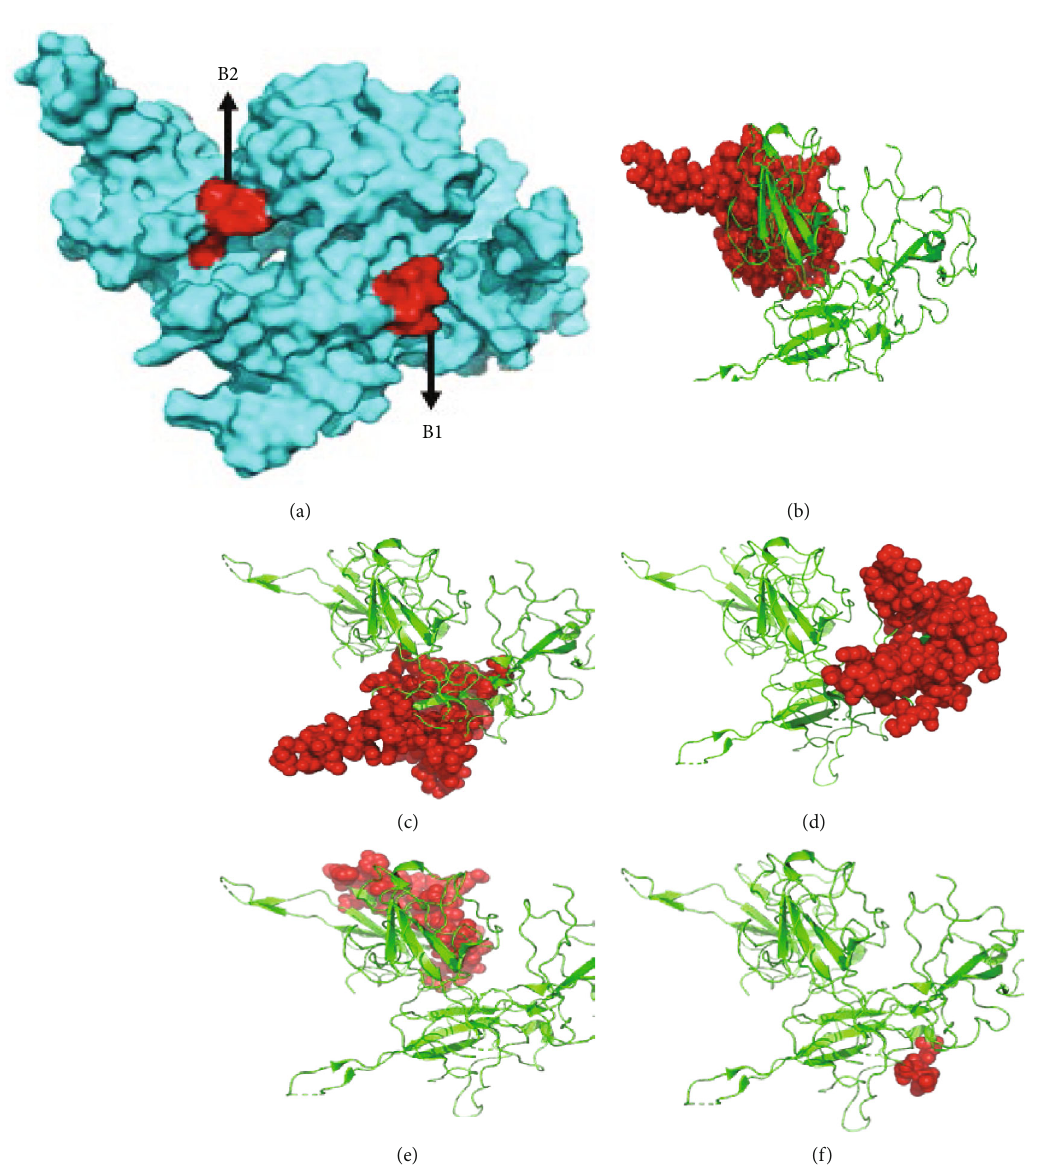
Figure 4: (a) Mapped out antigenic B cell linear epitopes (red) of the SARS-CoV-2 nucleocapsid protein. (b – f) The antibody recognition of SARS-CoV-2 denatured antigens (red spheres) in (b) D monomer, (c) B monomer, (d) C monomer, (e) A monomer, and (f) B